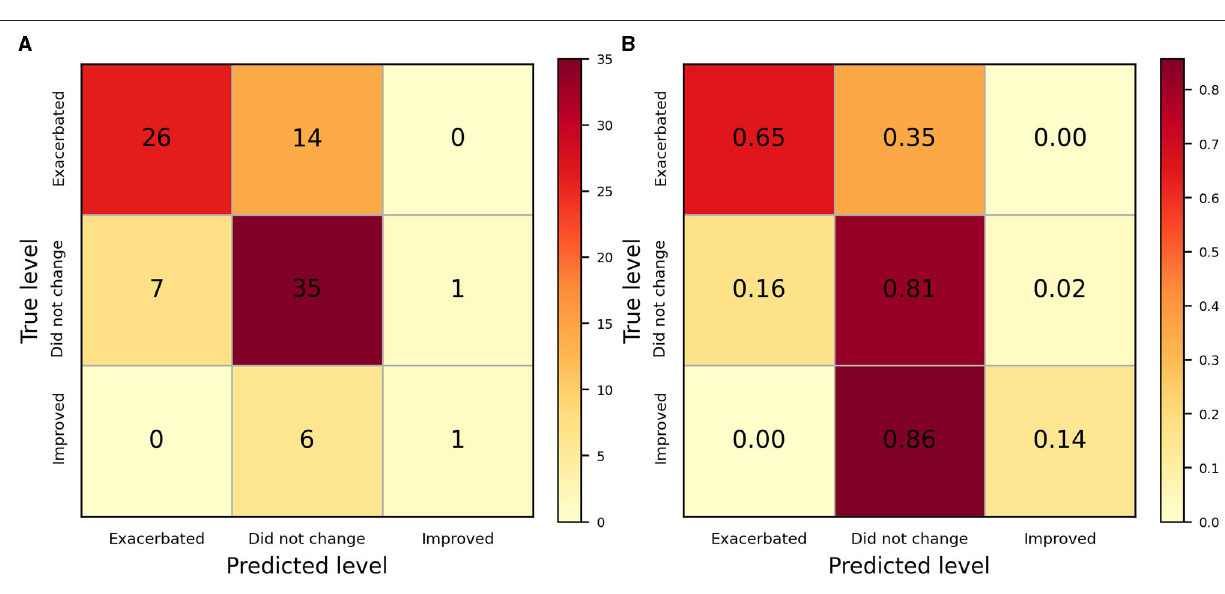
better than the chance level. In general, SSA-PNN exhibits the best adaptability for small